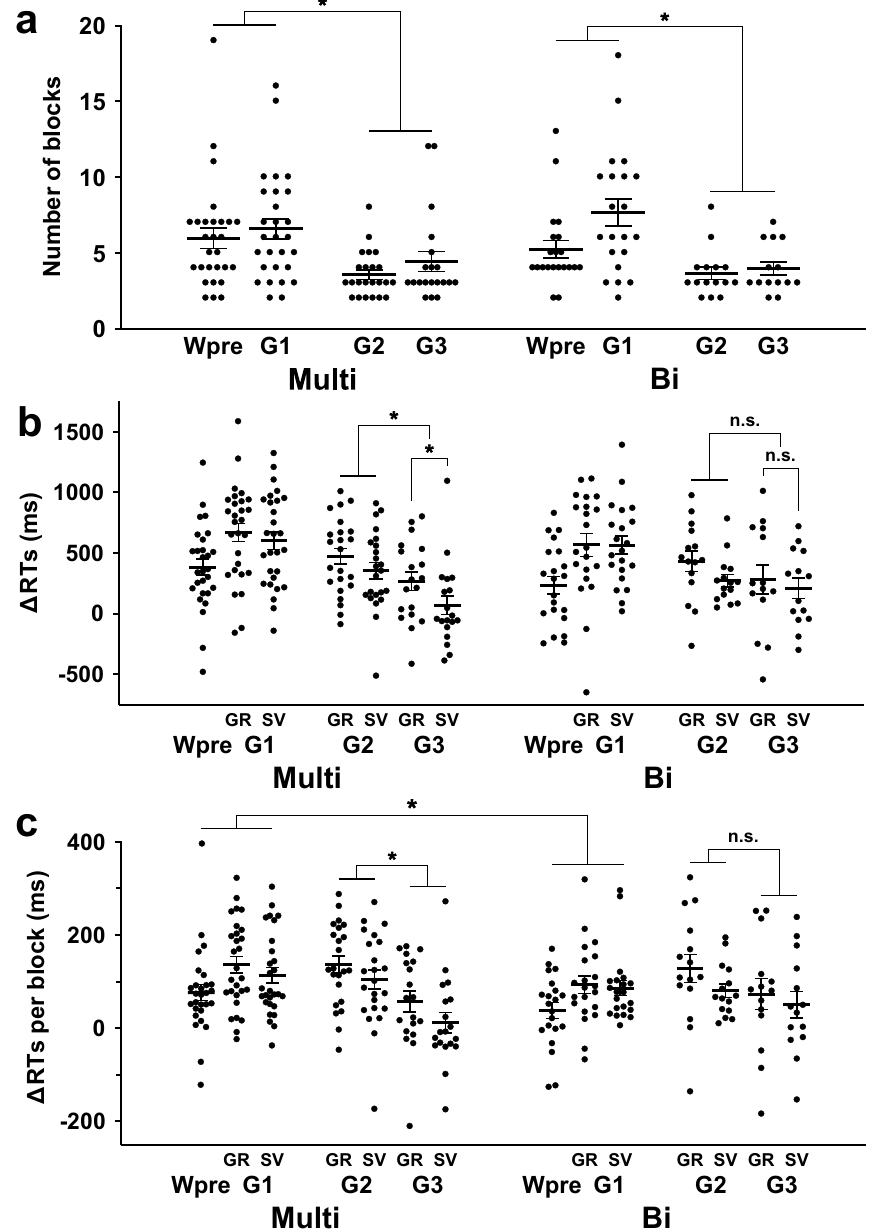
Figure 3. Group differences in the progressive acquisition of Kazakh grammars. ( a ) The mean numbers of blocks needed for the participants to reach criterion under each condition, together with individual data points overlapped. The progressive acquisition of Kazakh grammars was observed from Wpre/G1 to G2/G3 for both Multi and bilingual (Bi) groups. ( b ) The reduction in RTs (∆RTs) from the first to last blocks. Significant differences were observed between G2 and G3, as well as between GR and SV Tasks under G3, only for the Multi group. ( c ) ∆RTs per block, showing a significant group difference under the Wpre/G1 conditions. Error bars indicate standard errors of the mean (SEM). * p < 0.05; n.s., not significant ( p > 0.1). These images were created using GraphPad Prism (ver. 9.0.1, https:// www. graph pad. com) and Adobe Illustrator (as